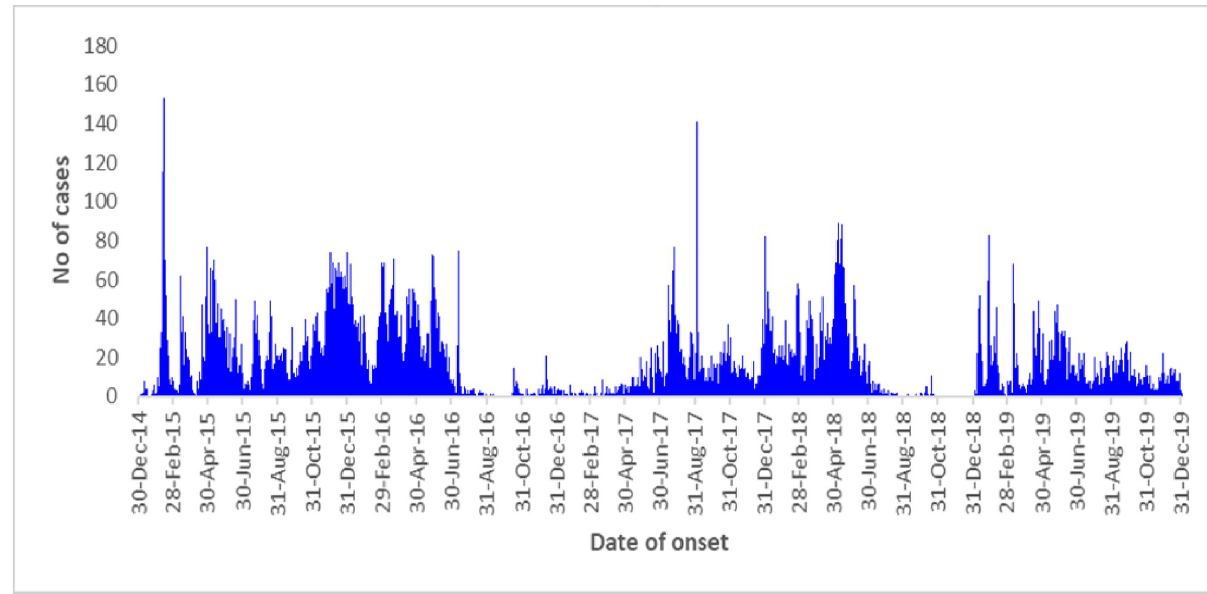
Fig 3. Epicurve showing the number of cholera cases reported by date of onset, Kenya, 2015–2019. Data source: Division of Disease Surveillance and Response, Ministry of Health, Kenya.